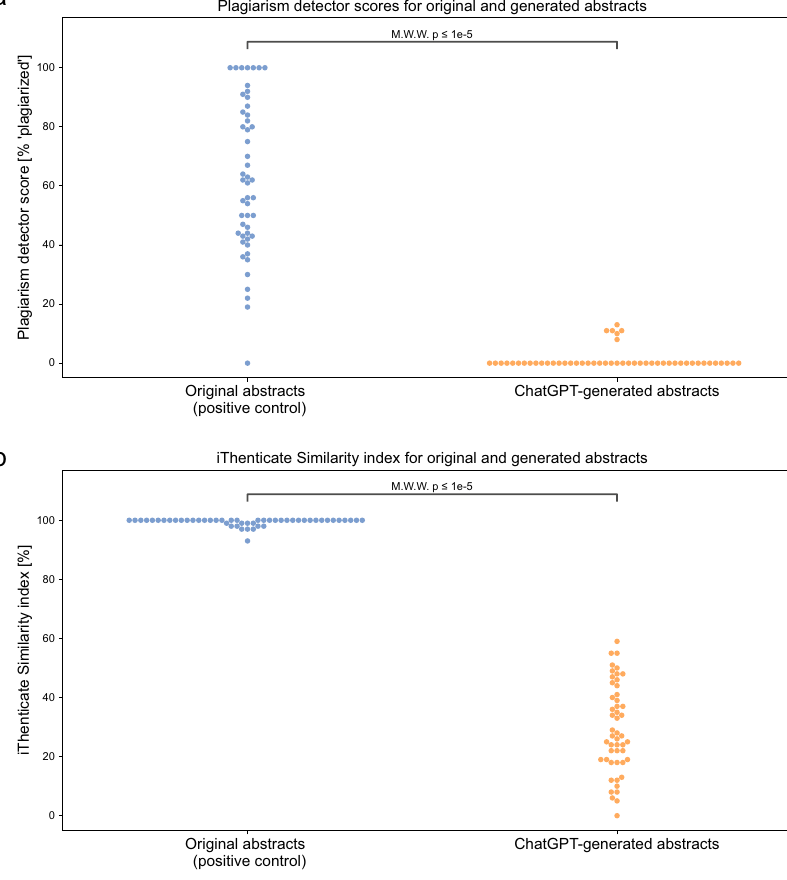
Fig. 3 Generated abstracts score lower than original abstracts on plagiarism detectors. a Plagiarism scores from plagiarism detector website, with higher % ‘ plagiarized ’ score indicating more matching text was found. b iThenticate Similarity Index for original abstracts and generated abstracts [%], with higher value meaning more similar text was found.